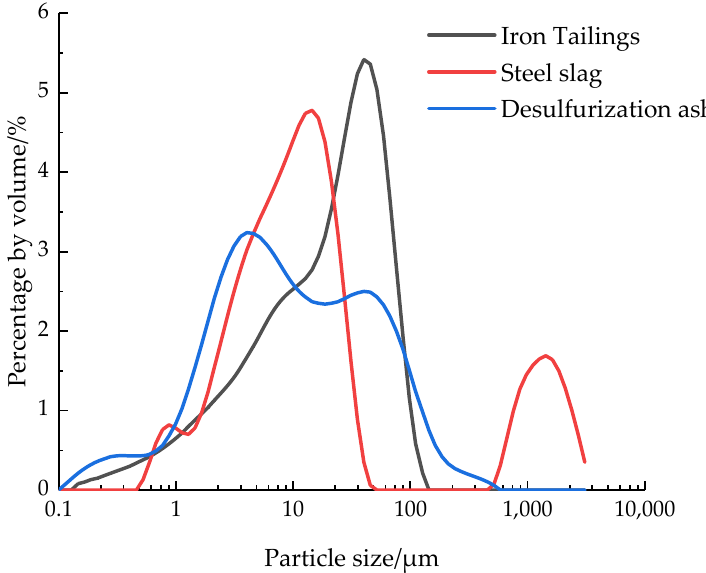
Figure 1. Particle size distribution of iron tailings, steel slag and desulfurization ash.